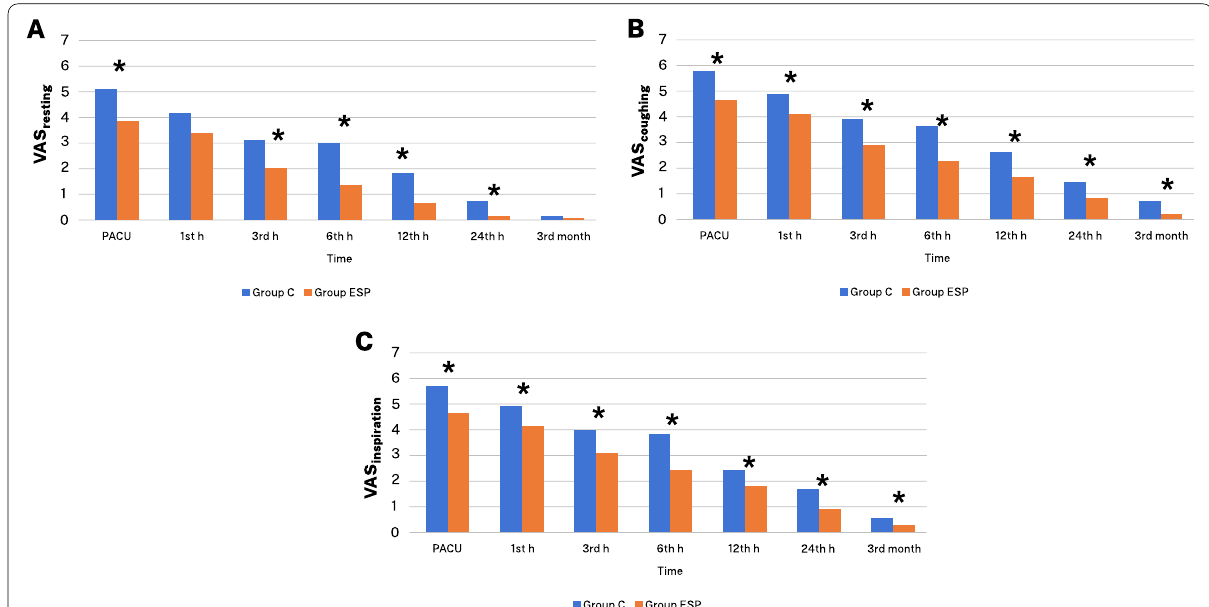
Fig. 2 A VAS resting scores of the groups at different time points. B VAS coughing scores of the groups at different time points. C VAS inspiration scores of the groups at different time points. Data are expressed as mean standard deviation. Abbreviations: VAS, visual analog scale; PACU, postanesthesia care ± unit; ESP, erector spinae plane. * p < 0.05 statistically significant according to group